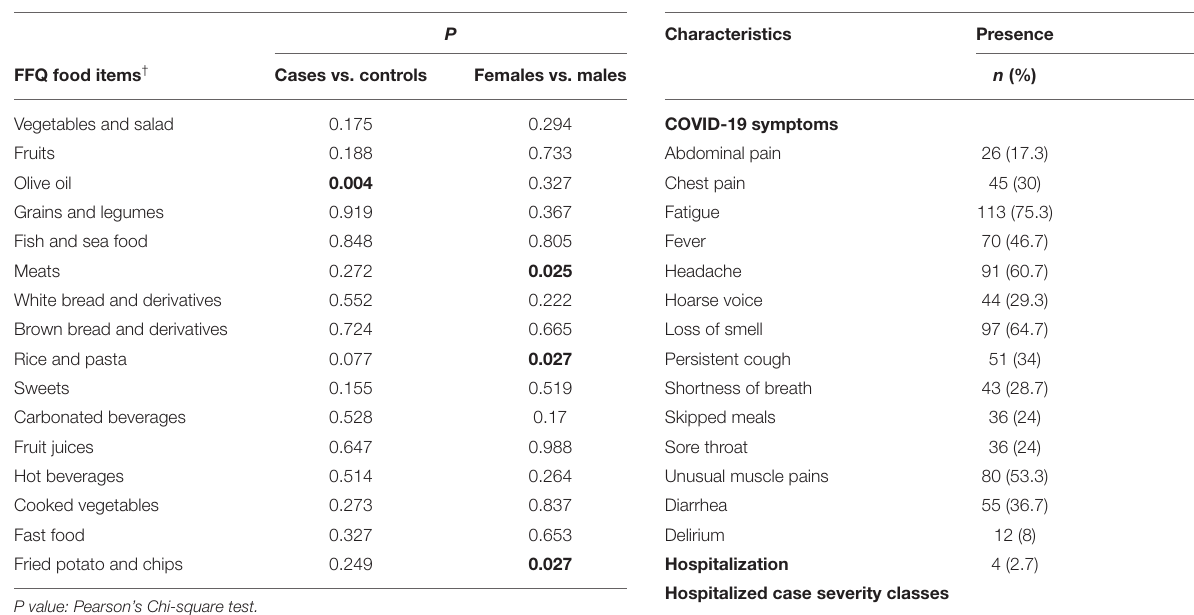
TABLE 5 | FFQ food items consumption. TABLE 6 | COVID-19 infection characteristics in the case group.